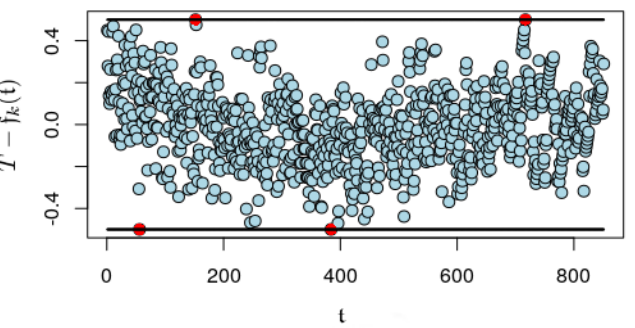
Figure 3. Blue dots represent differences between T and f k ( t ) . In 4 dots, M ( T − f k ( t )) and M ( T − f k ( t )) are reached, and we have colored them in red. Those are the 4 points mentioned in Proposition 5. Please observe how the maxima and the minima are alternatively